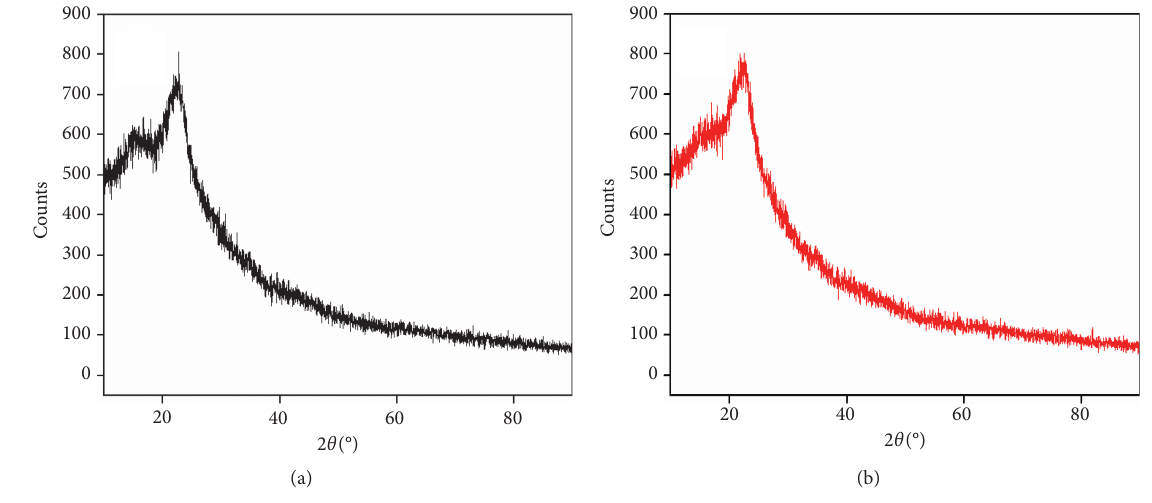
Figure 3: XRD image of (a) pinus-raw and (b) pinus-g-( AN/EA